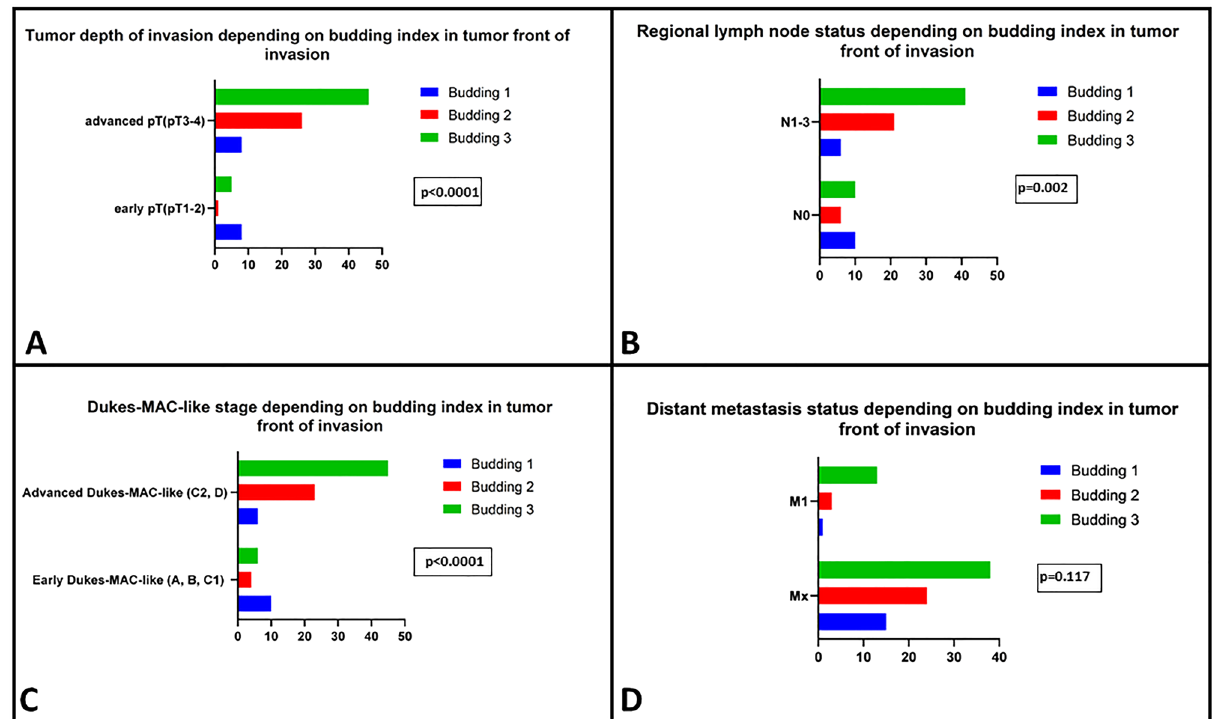
Figure 2. Budding index in the invasive edge of gastric cancer is directly associated with depth of infiltration ( A ), nodal status ( B ) and Dukes-MAC-like stage ( C ) but does not influence the risk for distant metastases ( D ).